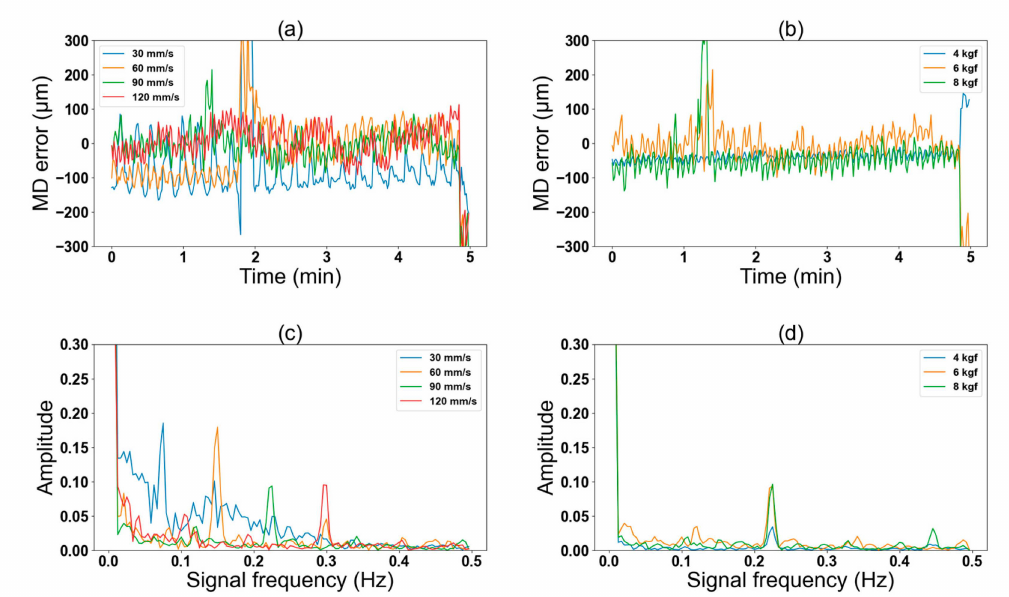
Figure 8. Effects of nip force variation on machine directional (MD) error by varying printing speeds: ( a ) predicted MD error at different printing speeds (set nip force = 6 kgf) and ( b ) at different nip forces (set printing speed = 90 mm/s) as a function of the time domain; ( c ) predicted MD error at different printing speeds (set nip force = 6 kgf) and ( d ) at different nip forces (set printing speed = 90 mm/s) as a function of the frequency